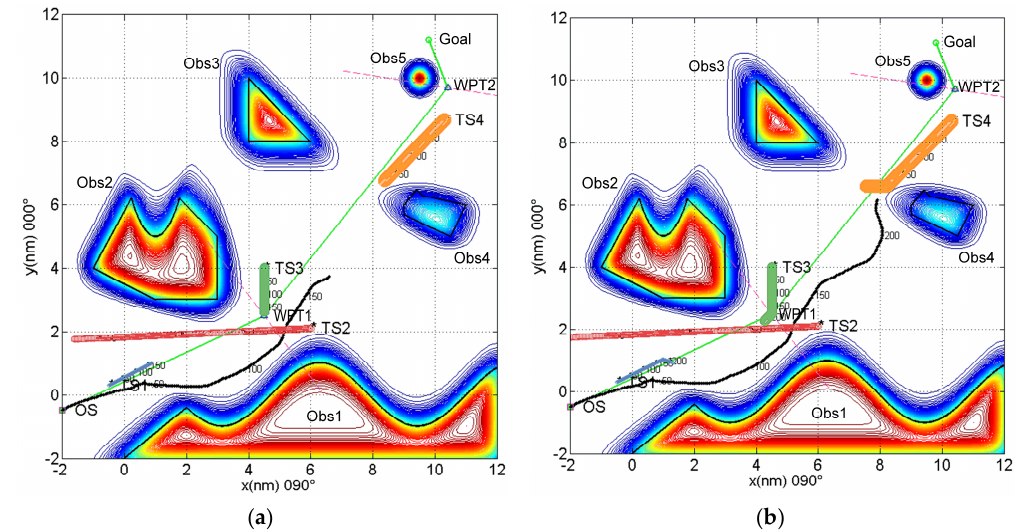
Figure 16. ( a ) When heading to WPT2, the own ship encounters TS4 in a head-on situation. It is noted that TS4 does not alter her course to starboard; hence, in the range of 4.6 nm to TS4, the own ship takes a substantial right turn 35° to pass on the port side of TS4. ( b ) The own ship takes a new course 065°, but there is a static obstacle Obs4 in front of her. Therefore, the own ship must avoid Obs4 and consider the influence of TS4. Finally, the own ship selects an optimal course to port and passes abaft the TS4 at a range of 0.6 nm due to the sudden course change 45° to starboard by TS4. In addition, the passing distance between the own ship and Obs4 is safe, approximately 1.0 nm.